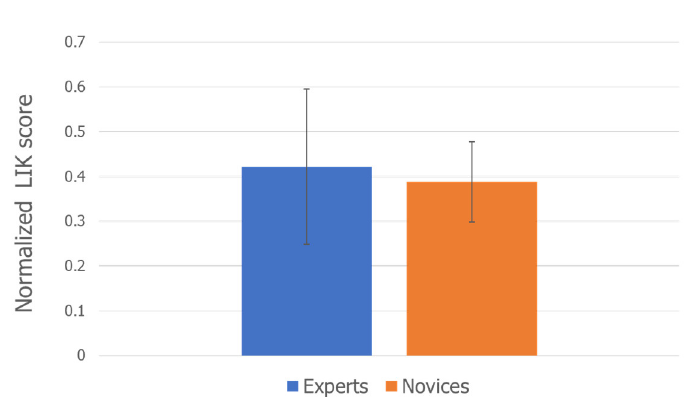
Figure 3. Median LIK score of the Experts (blue bar) and Novices (orange bar) related to the perceived mental effort demand across different flight phases. No statistical difference ( p = 0.73) was found between the two groups.